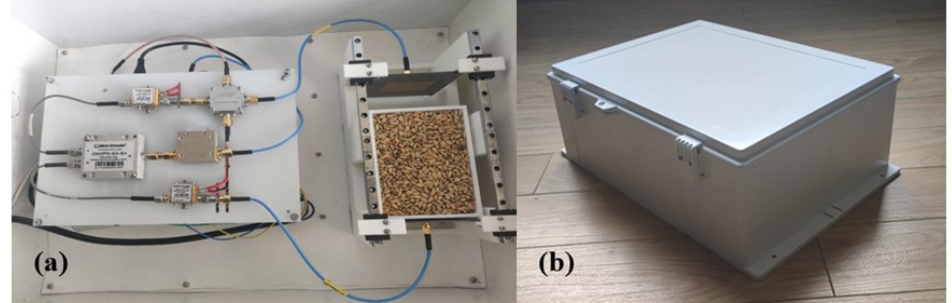
Figure 5. Integral measuring device: ( a ) inner structure; ( b ) external